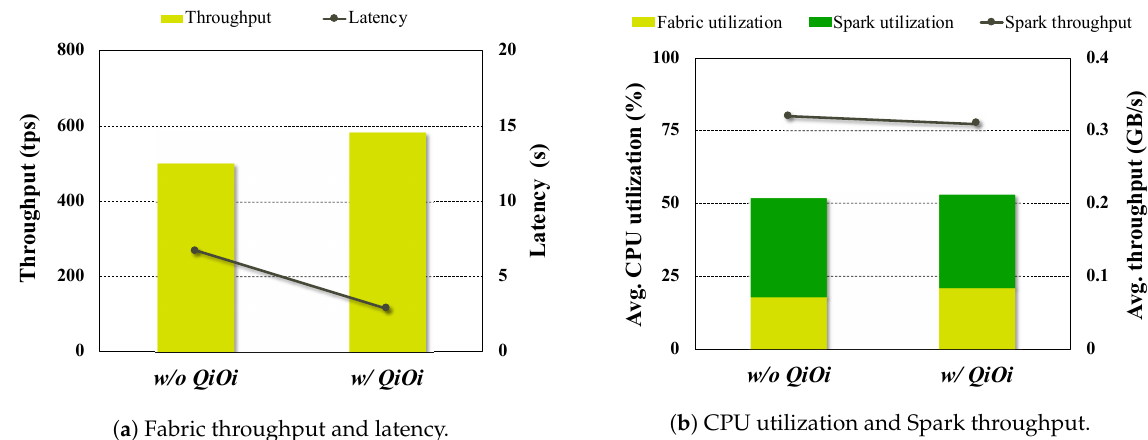
Figure 12. Impact of QiOi on Fabric running with Spark containers together.